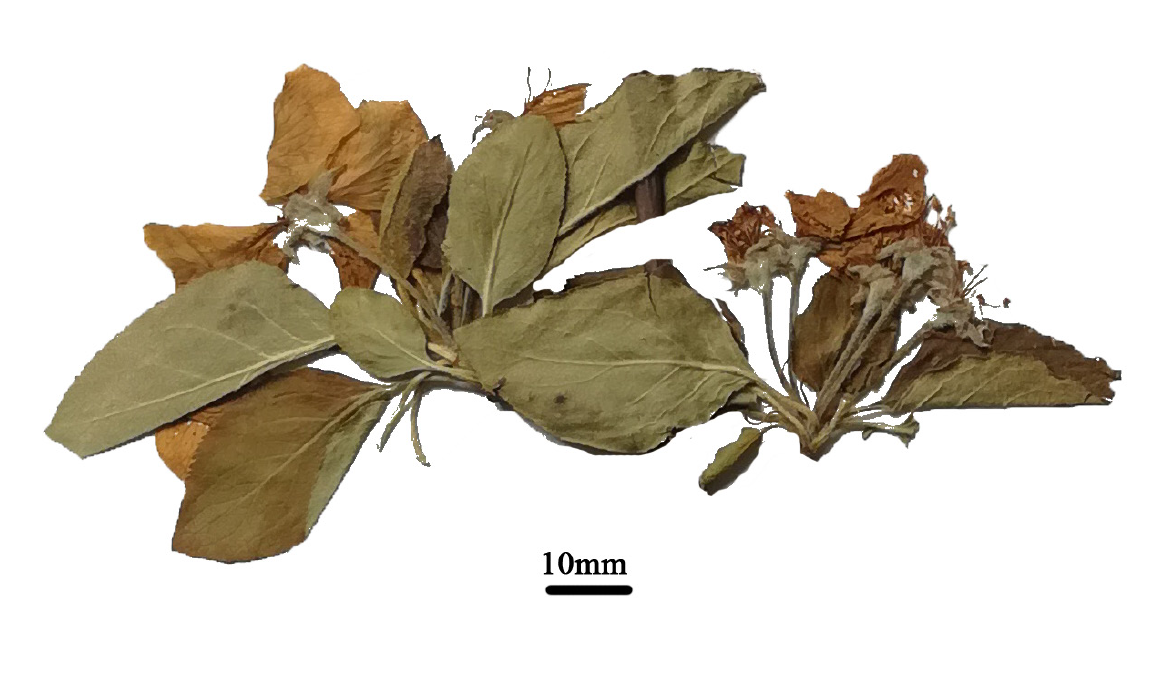
Fig. 16. Morphological characters of Malus kirghisorum Al.Fed. & Fed.;